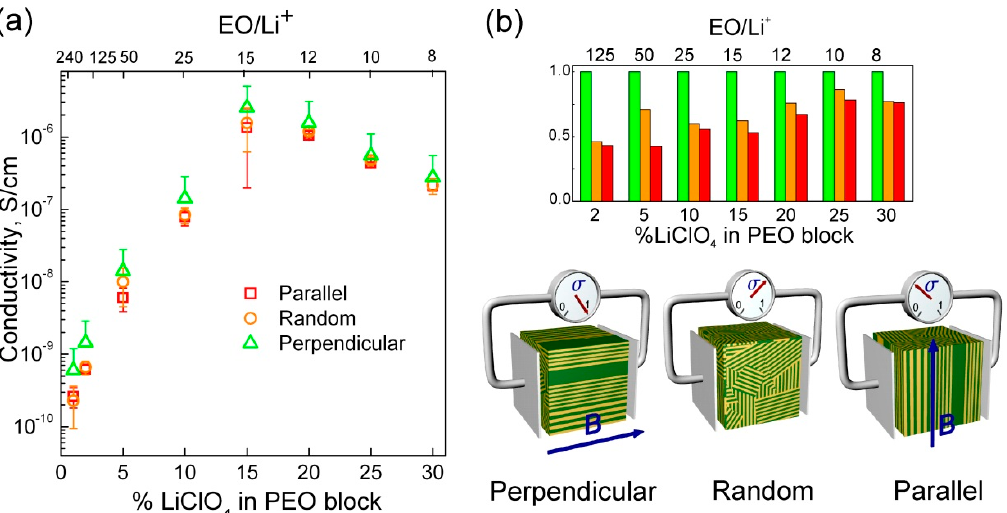
Figure 8 . ( a ) Room temperature conductivities as a function of lamellar domains orientation shown for samples with different ethylene oxide units to Li ion ratio. ( b ) Linear representation of conductivity data normalized to the conductivity of samples with perpendicular domains orientation (green bars). The error bars represent standard deviation of at least three independently repeated measurements for each data point.